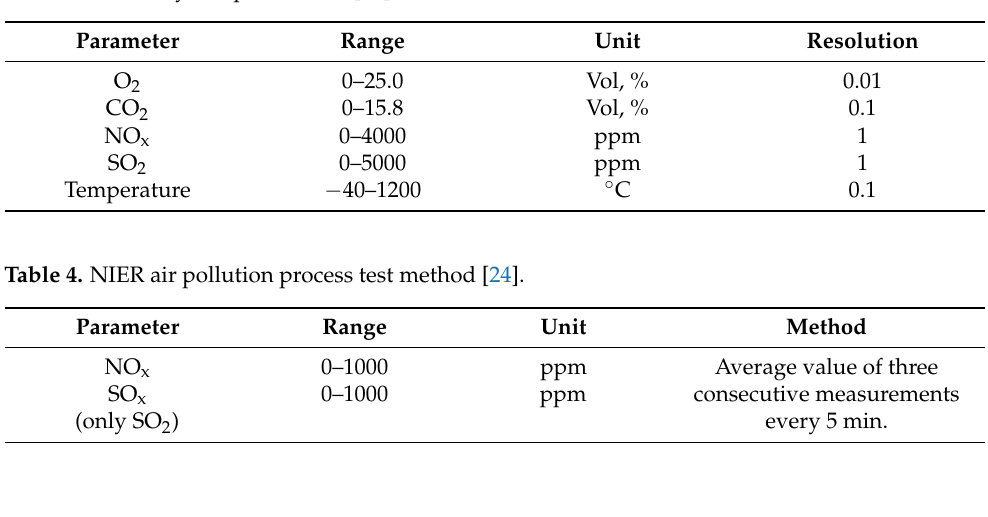
Table 3. Gas analyzer specification [20].